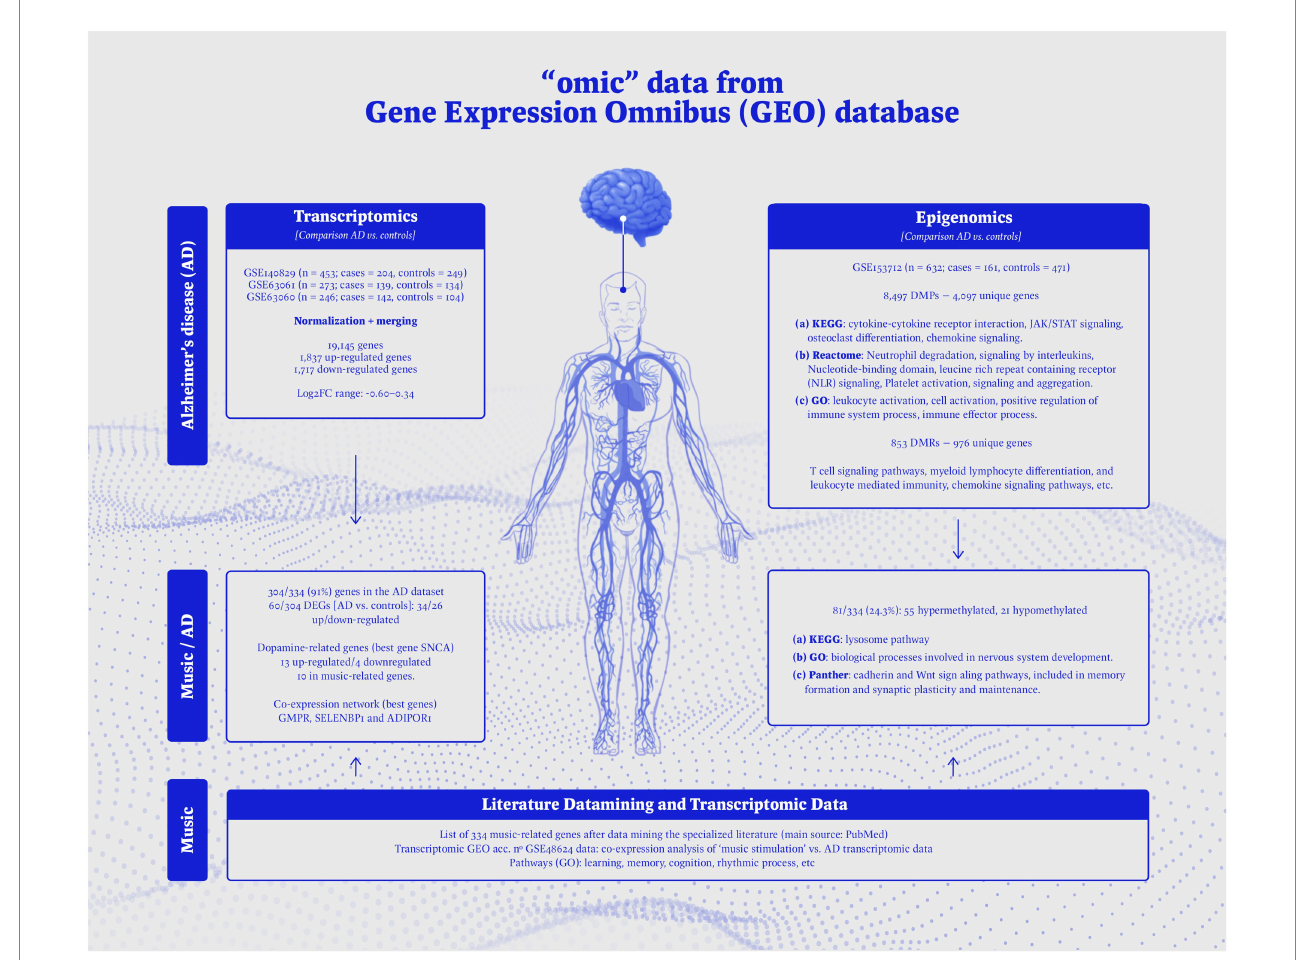
FIGURE 3 Overview on the -omic data used in the present study, and schematic representation of the main results